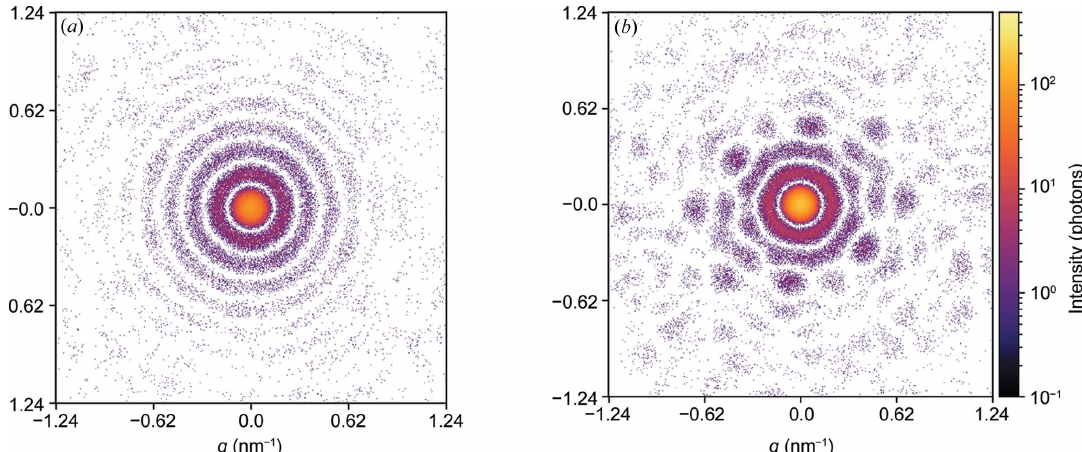
Figure 3 Diffraction patterns from single objects in a random orientation: ( a ) 5o6a [for TBEV in Fig. 1( a )]; ( b ) 5o6v [for TBEV with Fab-fragments in Fig. 1( b )]. Simulation parameters: 2.07 A˚ wavelength, 300 nm X-ray beam focus, 512 (cid:4) 512 pixel detector size, 400 m m (cid:4) 400 m m pixel size, 2.5 m sample-to- detector distance and 10 12 photons signal intensity at the